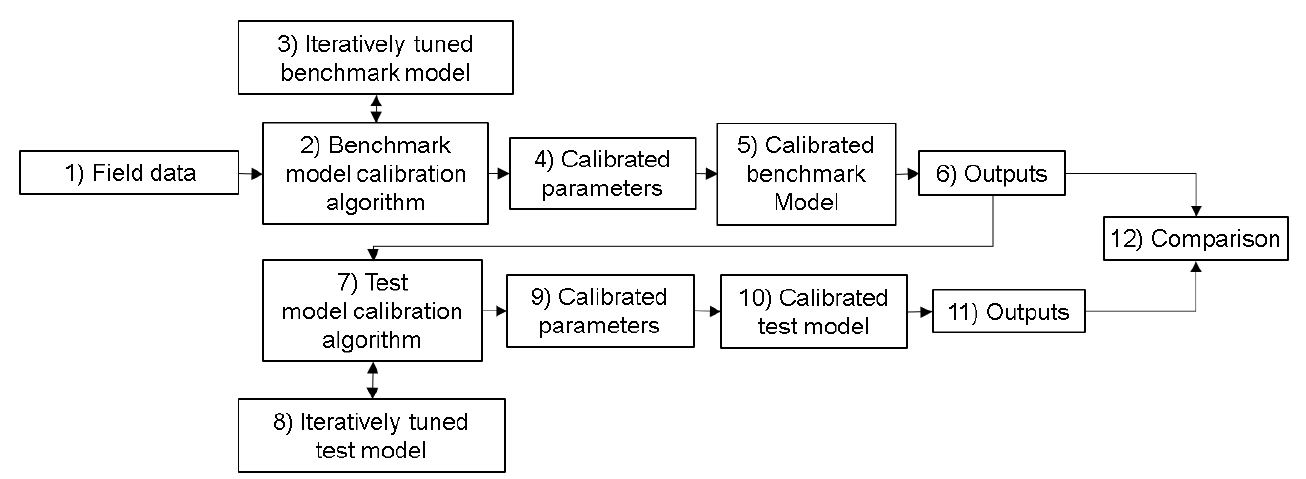
Figure 5. Generic setup for model